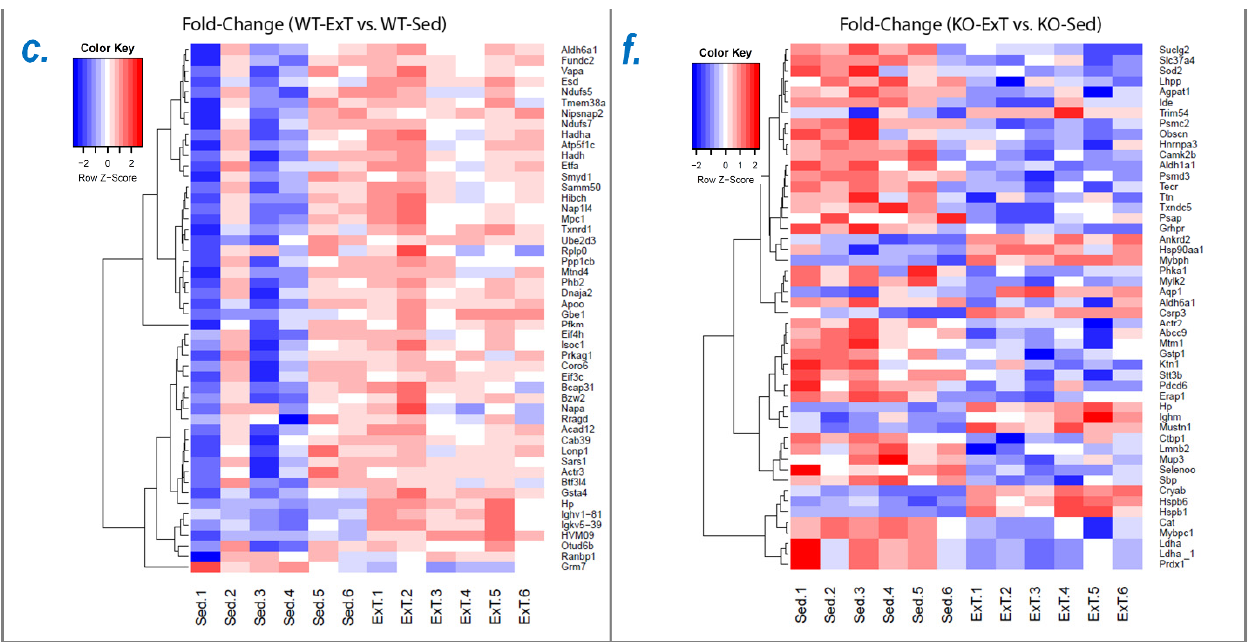
Figure 3. Differentially expressed proteins in TA muscles detected by mass spectrometry-based proteomics analysis with comparing WT-ExT to WT-Sed ( A ) and KO-ExT to KO-Sed ( B ) mice. ( a , d ) principal component analysis (PCA). The percent variance explained by each principal component is indicated on the PCA plot axes. ( b , e ) Volcano plots showing the log2 fold change (ExT/Sed) plotted against the –log10 p value, highlighting significantly changed proteins (red and green; p < 0.05 and an absolute fold change of 1.5, n = 6/group, moderated t -test). The vertical lines correspond to the absolute fold change of 1.5, and the horizontal line represents a p value of 0.05. Log 2 fold changes in WT-ExT and KO-ExT are represented as Log2FC WT-ExT and Log2FC KO-ExT , respectively. ( c , f ), heatmaps show the log2 of the top 50 differentially expressed proteins.